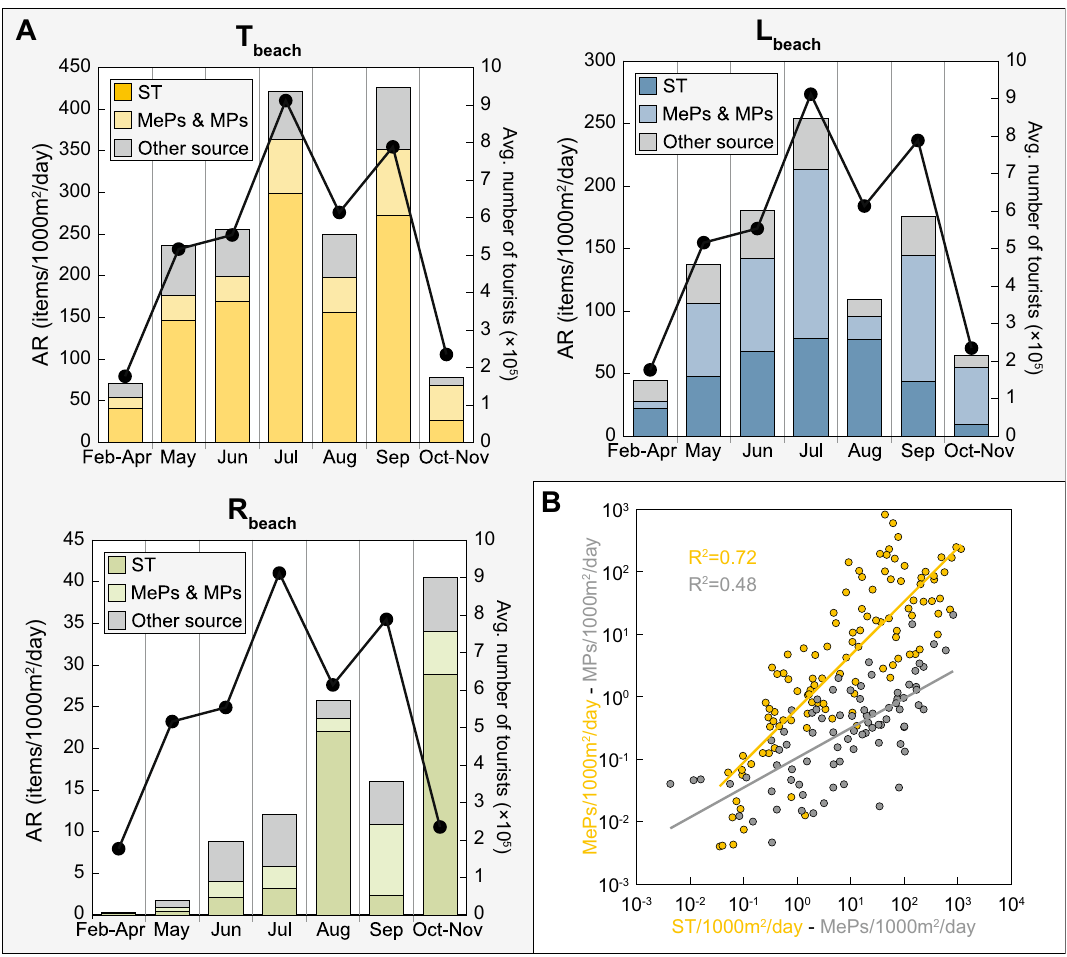
Figure 3. Accumulation rates of marine litter by source. ( A ) AR over time of the items from the “shoreline, including poor waste management, tourism and recreational activities” category (ST, dark color), the MePs and MPs (light color) and all the others categories (grey color). The black dots and lines represent the average monthly number of tourists welcomed in the islands where monitoring was performed (Supplementary Table S1). The decrease observed during August for the AR of the T beach and the L beach as well as for the average number of tourists is related to the absence of monitoring performed on the island of Mallorca, which is the most visited island and one of the most affected by marine litter. ( B ) Comparison between the AR of the MePs and the AR of the items from ST category (yellow); and between the AR of the MPs and the AR of the MePs (grey). The solid yellow and grey lines represent the power regression for both comparisons (both X and Y axes are on a logarithmic scale).